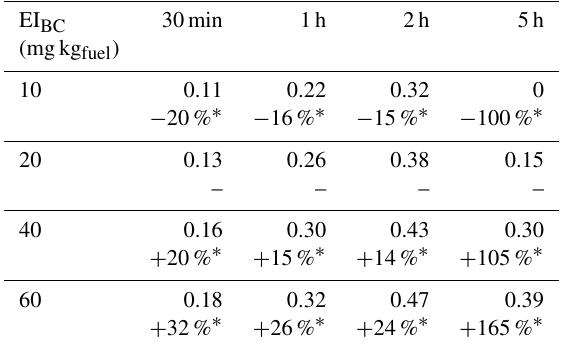
Table 7. Predominant optical depth for different black carbon mass emission